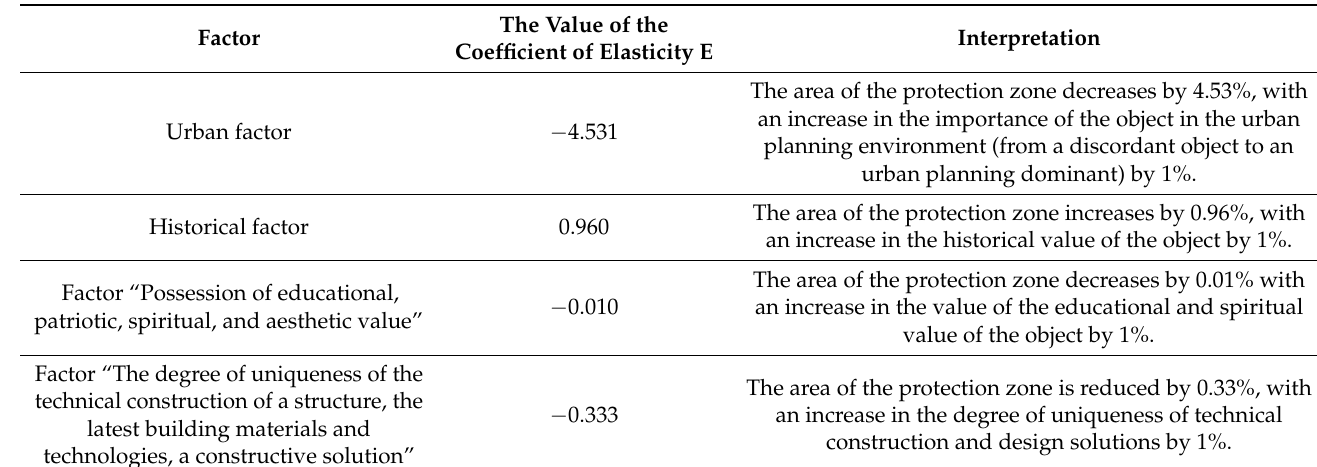
Table 4. Elasticity coefficients of a